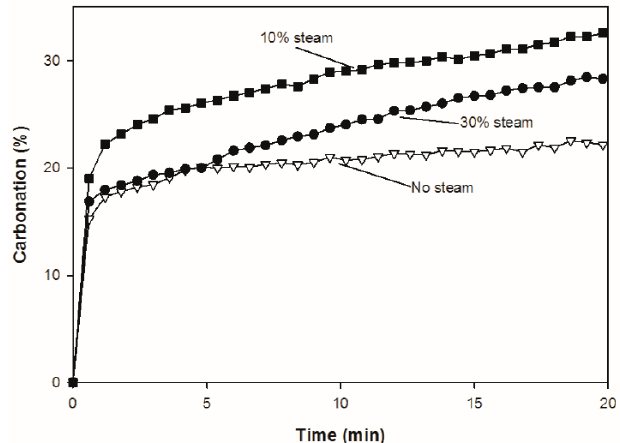
Figure 8. Comparison of carbonation conversion (%) over one cycle for CuO/CaO/CE pellets with 0, 10% and 30% steam.